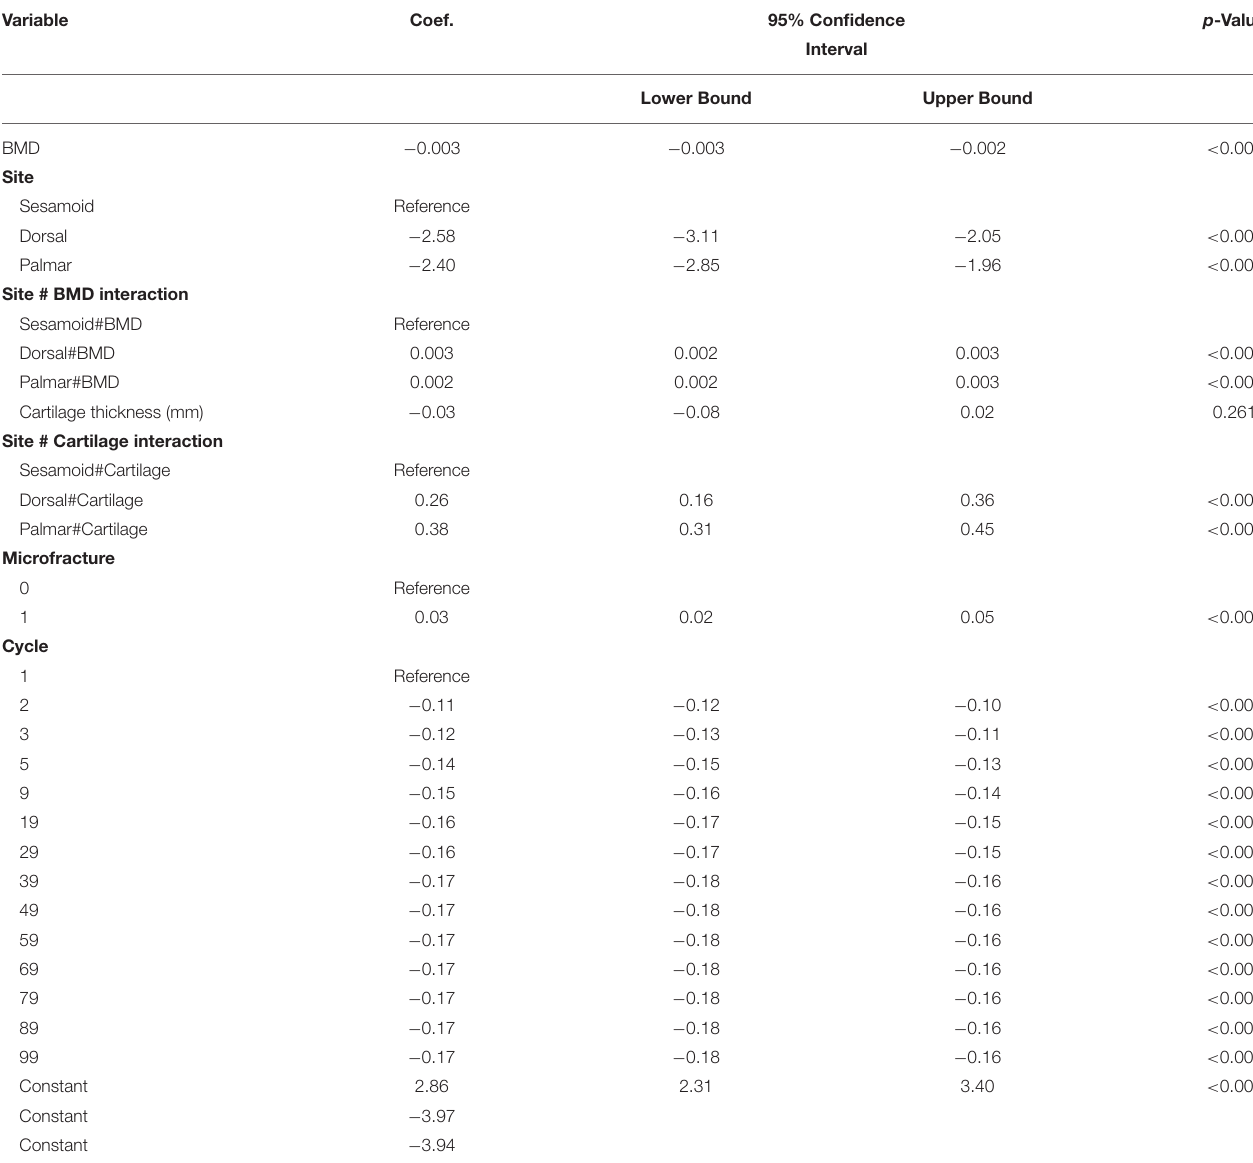
TABLE 4 | Multivariable mixed effects linear model estimated regression coefficients (Coef.), their 95% confidence intervals, and alpha level ( p -value) of factors associated with a total ∼ 10mm thick cartilage-bone specimen normalized hysteresis ( n = 420) in three sites (dorsal MCIII, palmar MCIII, and proximal sesamoid) within the metacarpophalangeal joint of n = 10 Thoroughbred